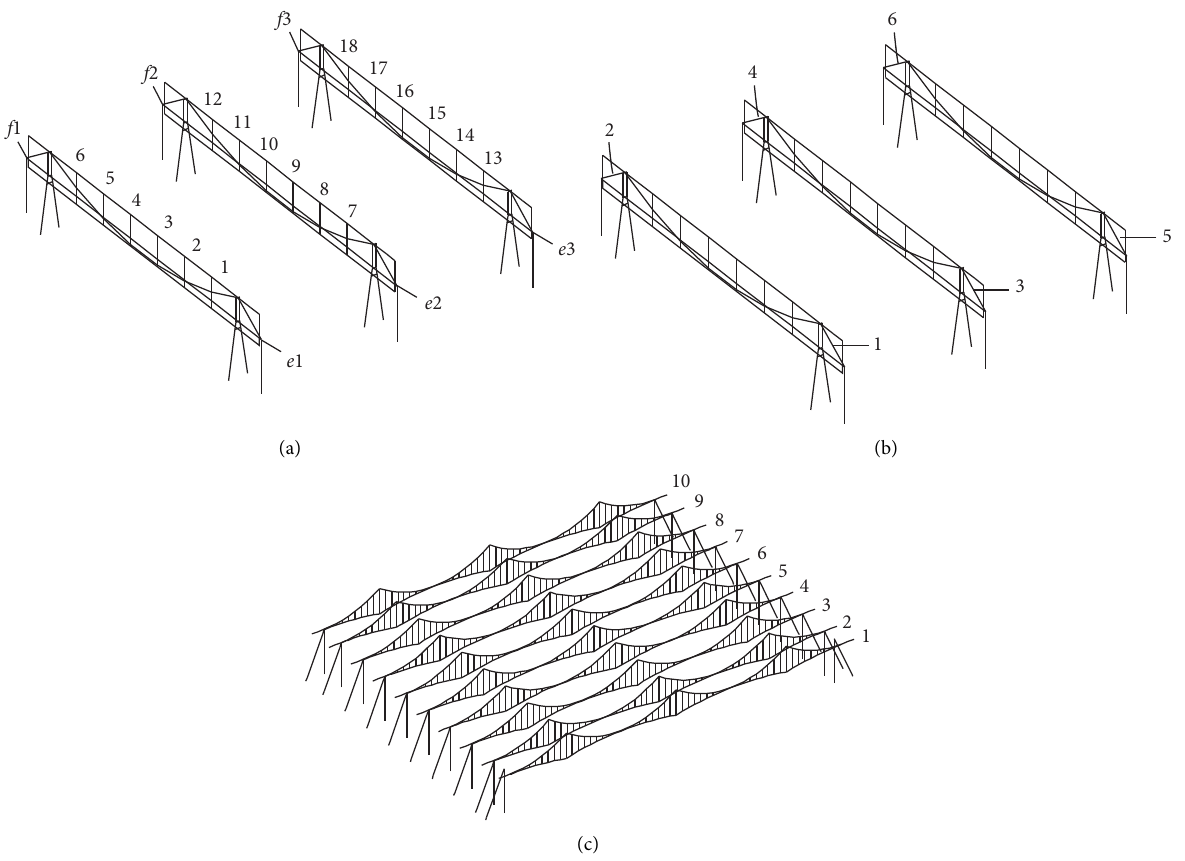
Figure 7: The numbers of all key notes in the whole structure: (a) nodes numbers of main load-bearing structure, (b) numbers of main load- bearing structure outer inclined cables, and (c) numbers of secondary load-bearing structure’s cable